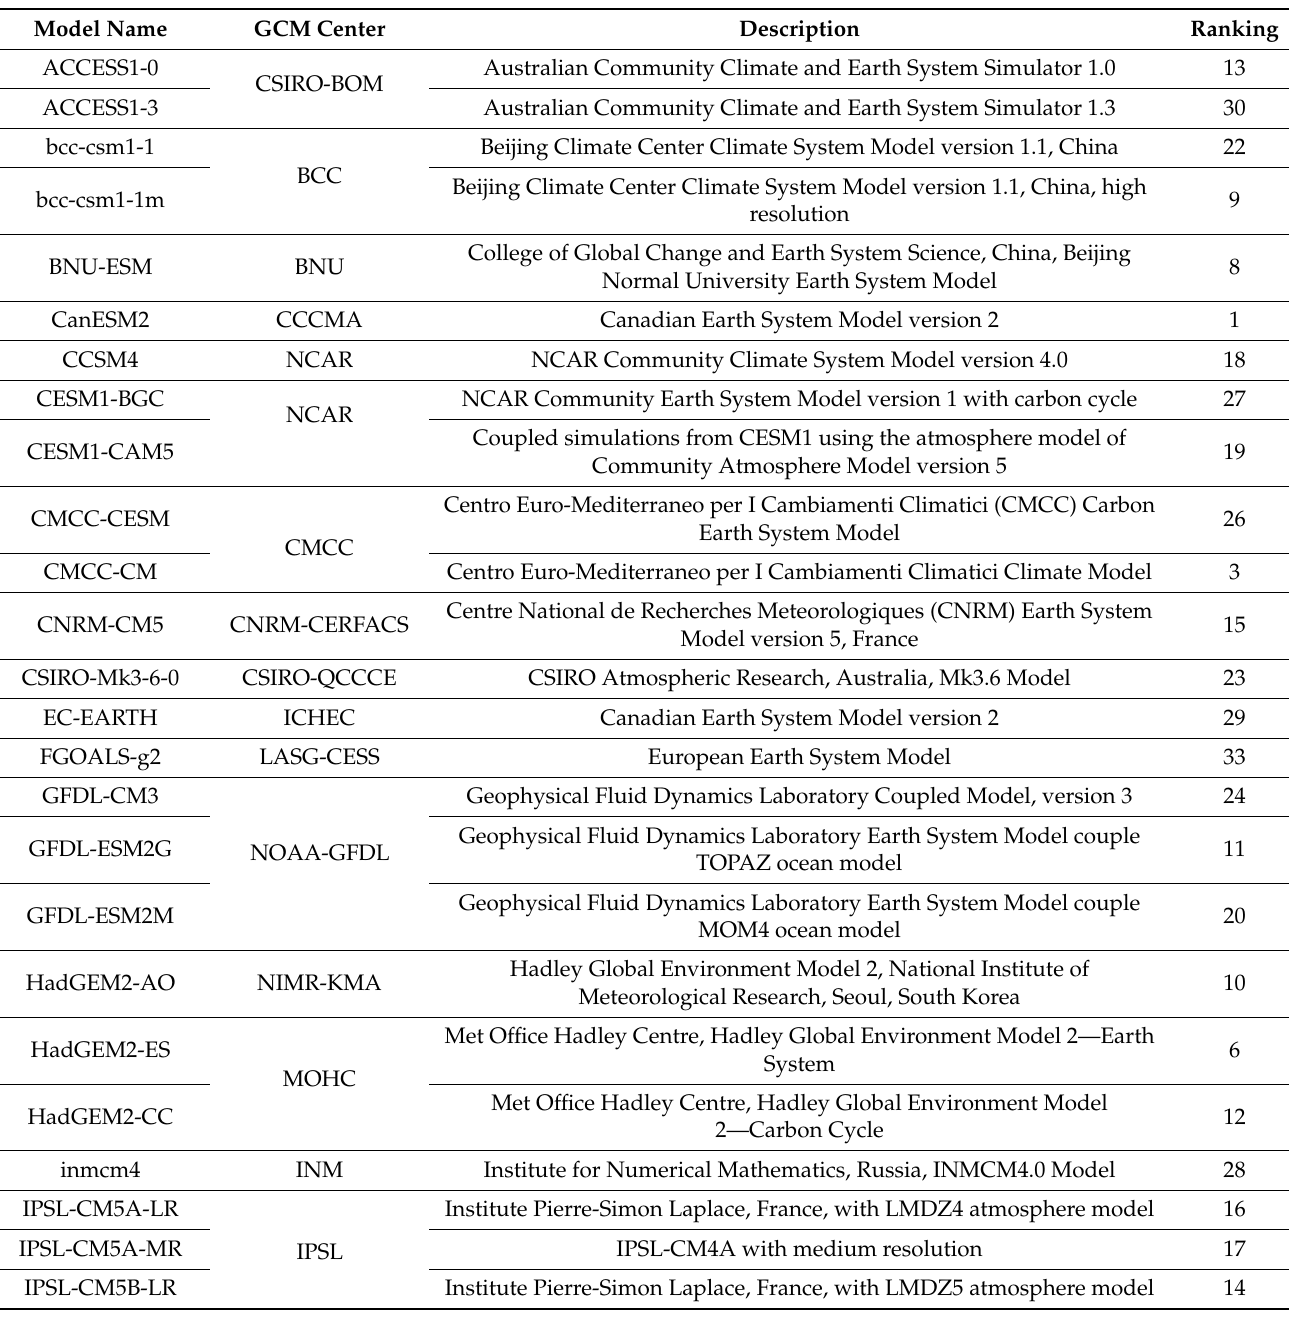
where n = total grid points; m = model; w n = weight index of individual grid points; s = model simulation value (average of the selected period); o = observed value (average of the selected period); and σ 2 = variance of observation data. Formula (1) was used to calculate the difference between the simulated grid and the observation data in all GCMs where the total number of grids ( n ) = 6 (Figure 1b), the number of models ( m ) = 33, and w n = 1. Formula (2) was used to standardize the variance, calculate the scores of all GCMs, and then sort them. The list of 33 GCMs and the ranking results of the performance index are shown in Table 1. Table 1. The list of 33 GCMs (refer to PCMDI website (https://pcmdi.llnl.gov/mips/cmip5/availability.html, accessed on 24 May 2021)) and the results of performance ranking (ranking was made by this